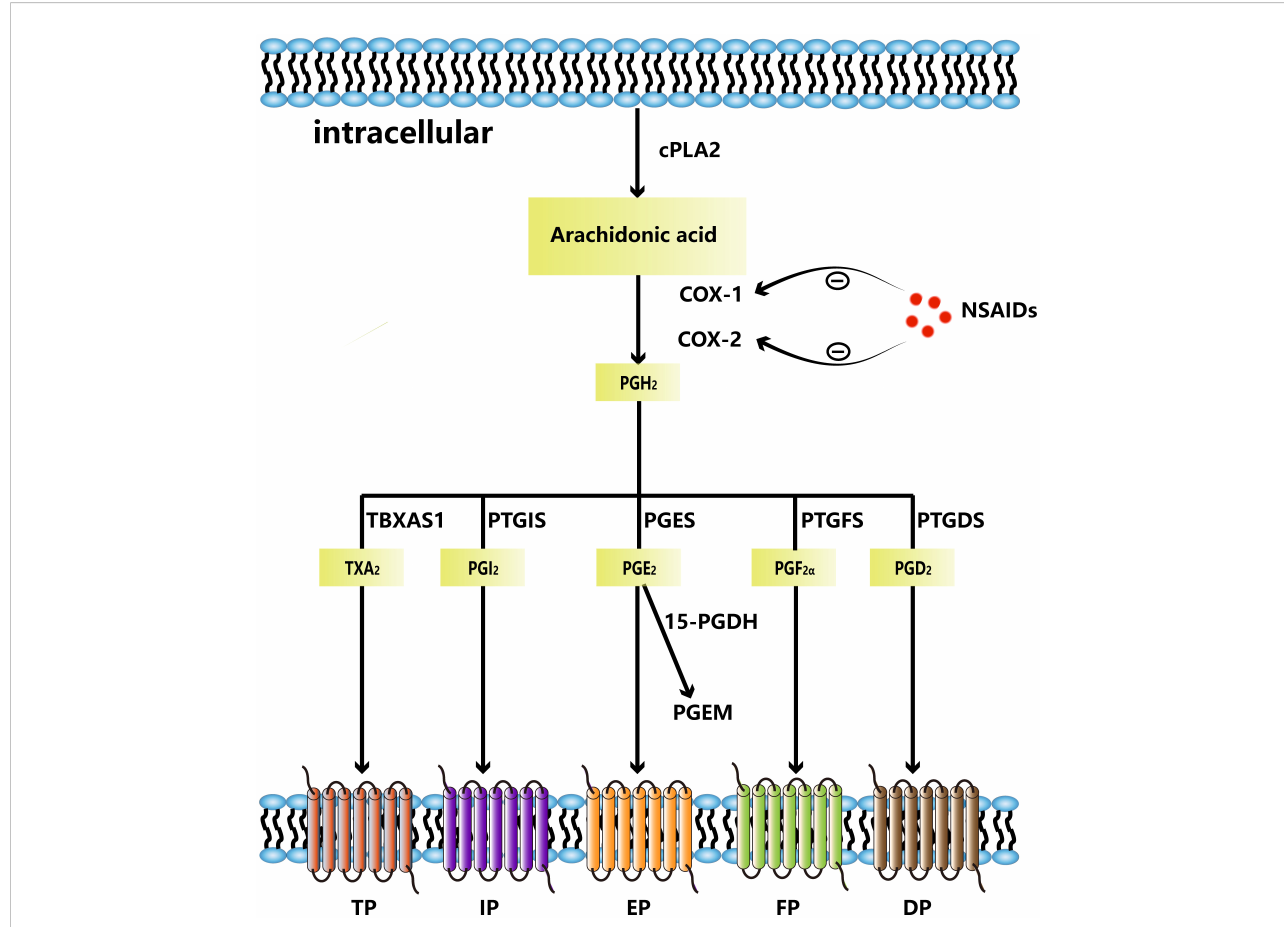
FIGURE 1 Arachidonic acid is metabolized to PGH 2 by COX-1 and COX-2. NSAIDs can inhibit COX-1 and COX-2. PGH 2 is metabolized to thromboxane A2(TXA 2 )by TBXAS1,